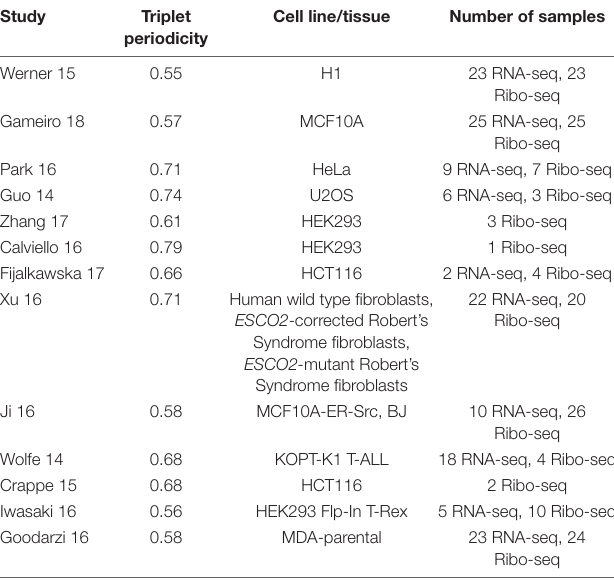
TABLE 2 | List of studies used for the ‘single transcript plot’ analysis with corresponding triplet periodicity scores, cell line/tissue and number of samples for each study (Guo et al., 2014; Wolfe et al., 2014; Crappé et al., 2015; Werner et al., 2015; Calviello et al., 2016; Goodarzi et al., 2016; Iwasaki et al., 2016; Ji et al., 2016; Park et al., 2016; Xu et al., 2016; Fija-Lkowska et al., 2017; Zhang et al., 2017; Gameiro and Struhl, 2018).